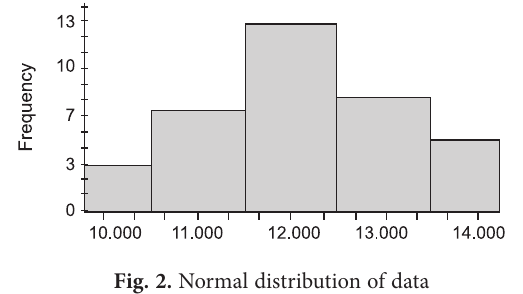
Fig. 2. Normal distribution of data